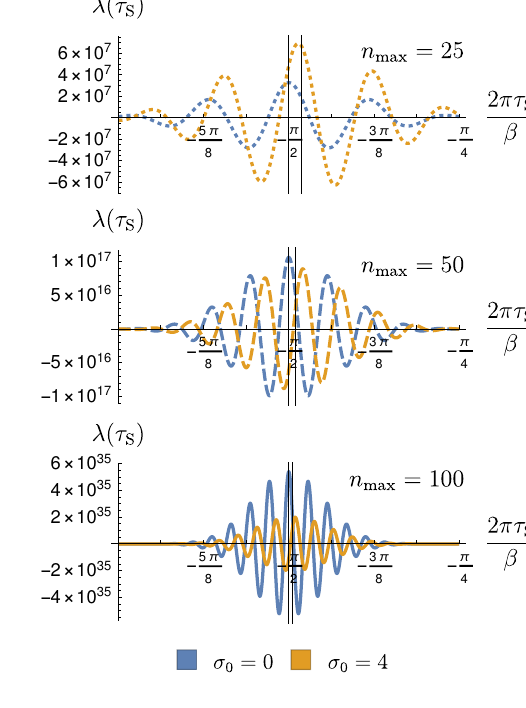
(b) Fourier coefficients λ 0 of sources which (c) Sources λ of figure 5(b) plotted as functions n S localize initial data on the horizon σ 0 = 0 and of Euclidean time τ S . The black vertical lines on one side of the black hole σ 0 = 4. mark the τ S values which maximize the ampli- tude of the oscillations in λ , with the left and right lines corresponding to σ 0 = 0 , 4 respec- tively. Figure 5. Initial data, localized by the minimization of variance V [Φ] about σ 0 , and sources that produce such initial